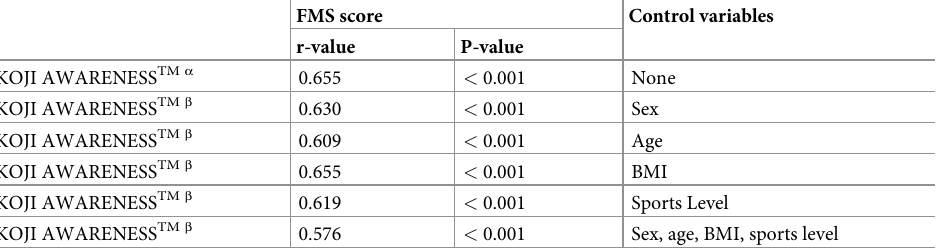
Table 3. Correlation and partial correlation between the FMS and KOJI AWARENESS scores (N = 57).